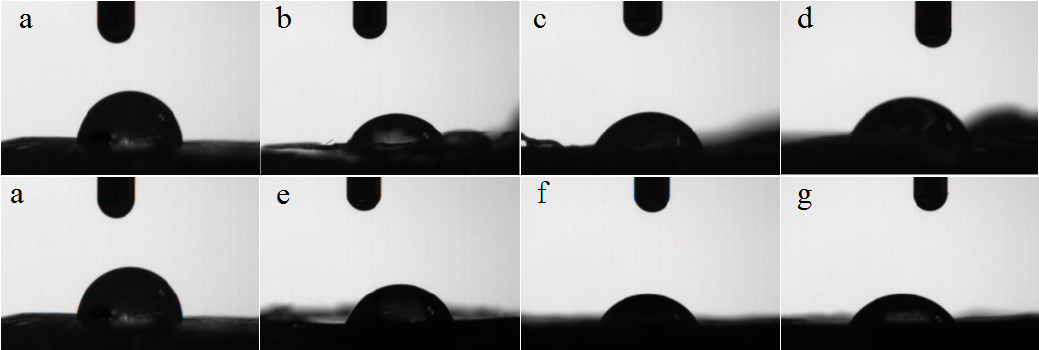
( f ) Figure 7. The SEM photographs o of PLLA and modified PLLA films:( a ) surface of PLLA film; ( b ) surface of m − PLLA − 3; ( c ) surface of m − PLAG − 3; ( d ) cross section of PLLA film; ( e ) cross section of m − PLLA − 3; ( f ) cross section of m − PLAG − 3.